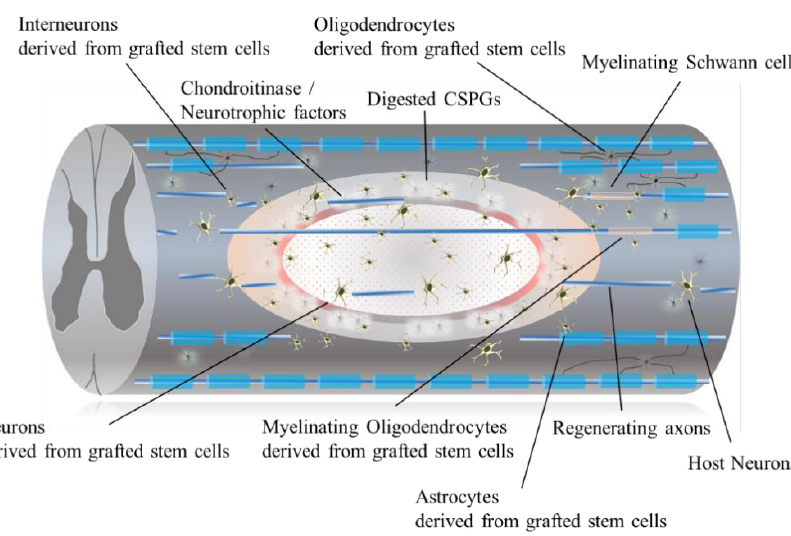
Figure 2. The diagram shows the pathophysiological change following stem cell transplantation. The transplanted stem cells differentiate into neural cells of the three lineages: neurons, astrocytes, and oligodendrocytes. Neurons and interneurons derived from grafted stem cells form new synaptic circuits and connectivity between host neurons and axons. Grafted stem cells secrete neurotrophic factors that improve morphological and behavioral outcomes after experimental SCI. Oligodendrocytes derived from grafted stem cells remyelinate damaged host axons. Regenerated and remyelinated axons pass throw the injured lesion and connect to other host neurons supported by interneurons and glial cells derived from grafted stem cells.